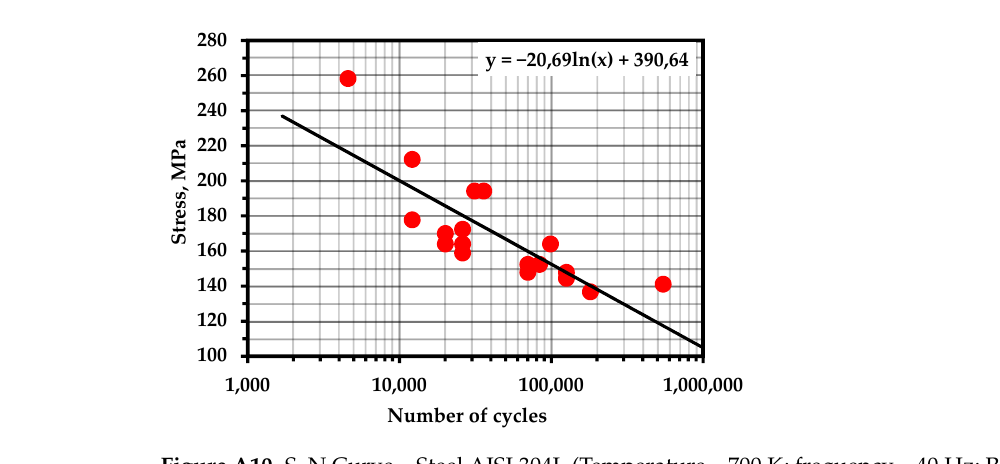
Figure A9. S–N Curve—Steel AISI 304LN (Temperature—293 К ; frequency—30 Hz). Source—Base Total Material.